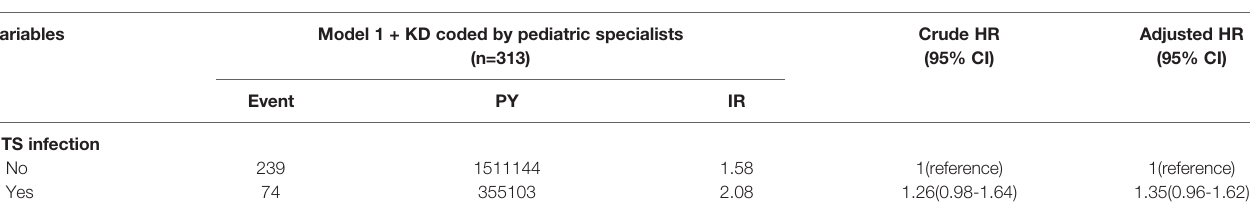
TABLE 4 | Sensitivity analysis (Model 2).